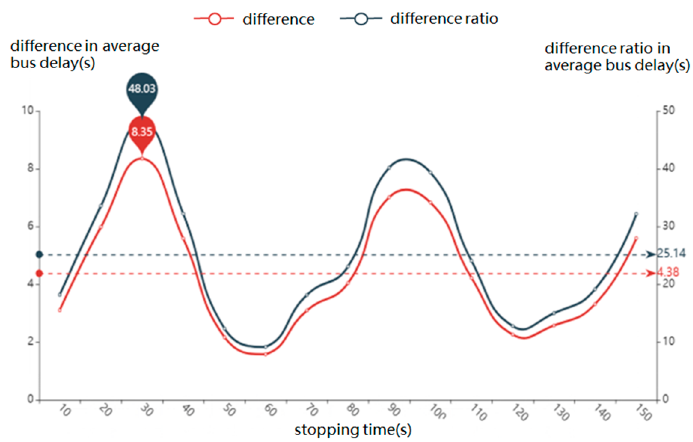
Figure 10. Change in average delay for each stopping time in the downstream direction.